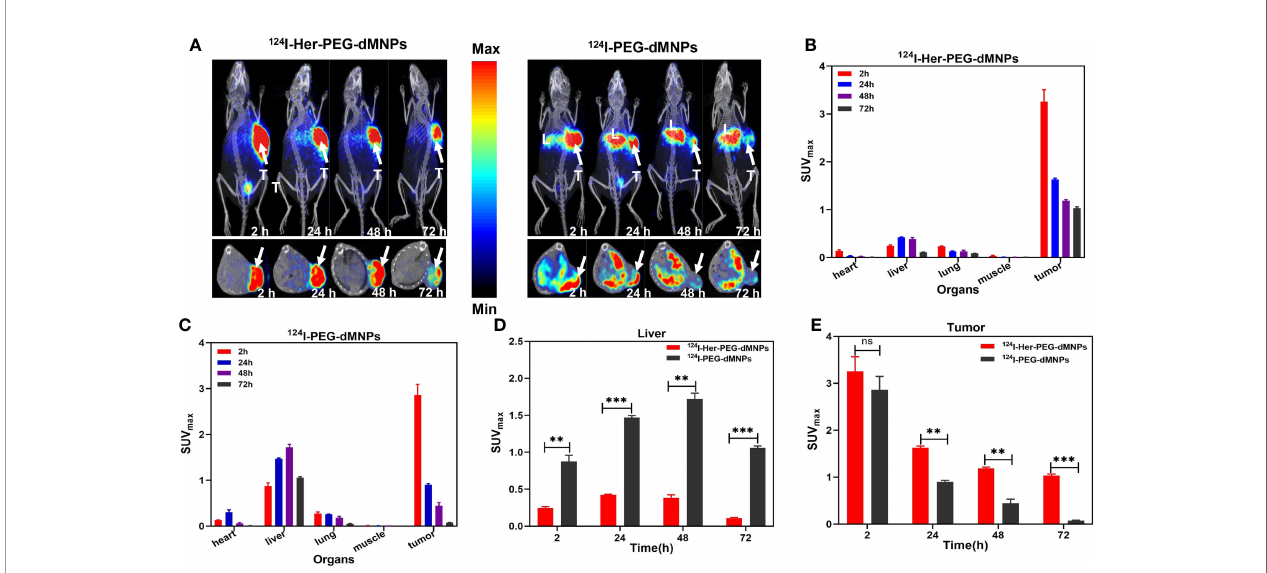
FIGURE 3 | (A) Micro-PET/CT imaging of 124 I-Her-PEG-dMNPs and 124 I-PEG-dMNPs in the gastric cancer PDX model at 2, 24, 48, and 72 h post-injection (the white arrows depicted the tumors; L, liver; T, tumor). (B, C) The SUVmax of the organs in the PDX model based on semiquanti fi cation of ROIs. The SUVmax of the liver (D) and tumor (E) based on micro-PET/CT imaging of ROI. The data were expressed as SUVmax ± SEM. All the numerical data are presented as mean ± SD. *P < 0.05; **P < 0.01; ***P < 0.001 by two-way ANOVA. The symbols **, *** indicates statistically signi fi cant, very statistically signi fi